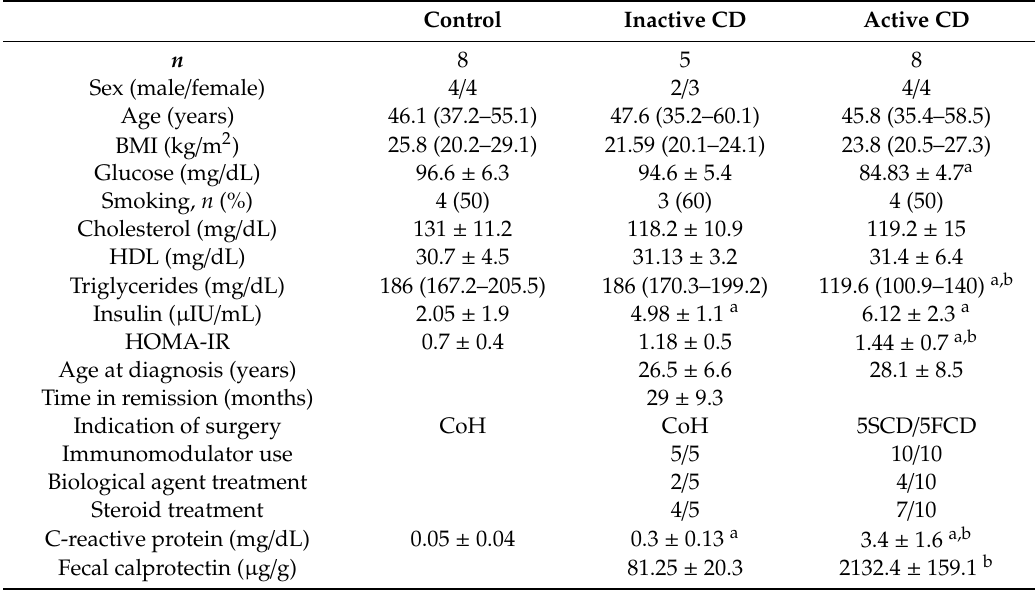
Table 1. Demographic and clinical characteristics of the